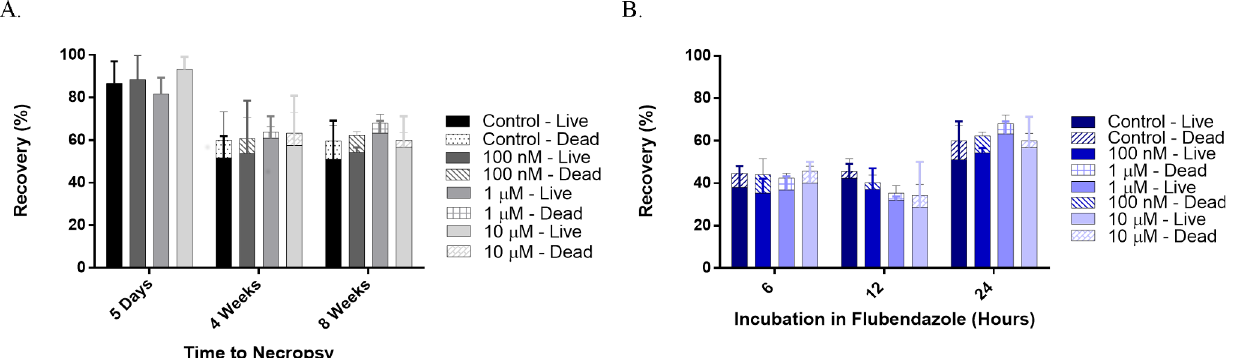
Fig 1. Effect of FLBZ on recovery of exposed and transplanted adult B . malayi male and female worms from the peritoneal cavity of na ï ve jirds. A. Five day, four week, or eight week maintenance in jirds after transplantation following 24 hr in culture. Data is a combination of two experiments. In experiment one 20 worms (10 male and ten female) were transplanted into each of three jirds for all treatment groups and maintained for 5 days or 4 weeks. Thirty worms (15 male and 15 female) were transplanted into each of three jirds per treatment group in experiment two and maintained for 4 weeks or 8 weeks. The 4 week data from each experiment did not differ significantly, therefore, they were combined for presentation purposes. B. Worm recovery eight weeks after transplantation following 6, 12, or 24 hr exposure to FLBZ in vitro . Thirty worms (15 male and 15 female) were transplanted into each of three jirds per treatment group, following the appropriate duration of in vitro exposure to FLBZ. Bars indicate the mean recovery of worms, both male and female, from each jird in a treatment group. Lines represent the standard